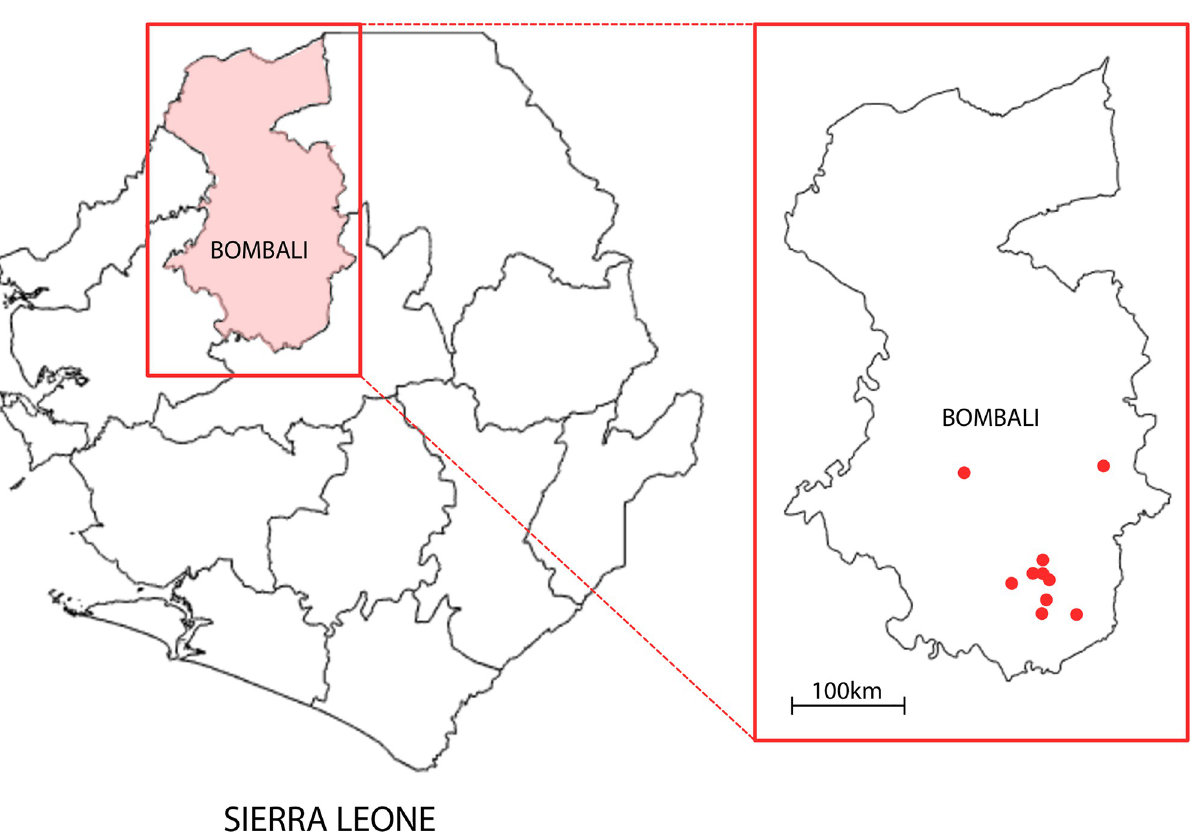
Fig 2. Survey locations in Sierra Leone. The survey was conducted in the district of Bombali over a period of three weeks. Ten different locations (red dots) were selected to obtain a representative sample of the population in rural areas of the country.